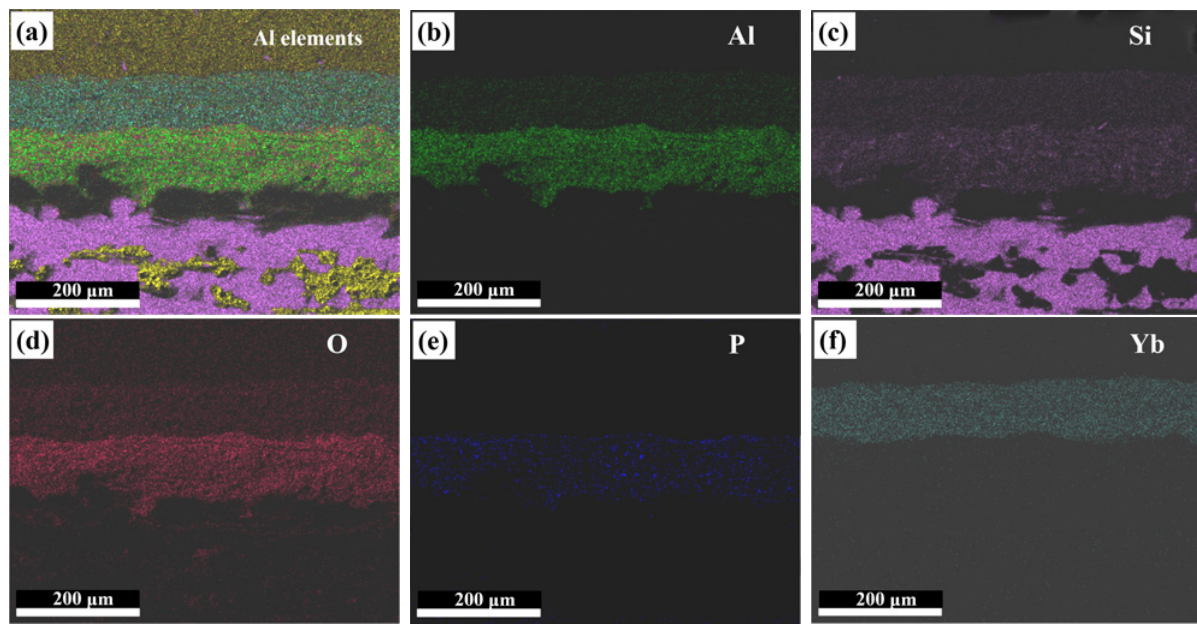
Fig. 6 Cross-section EDS element mapping scan analysis of tri-layer Yb 2 Si 2 O 7 /ASM/SiC coating-coated C f /SiC sample. 3. 2